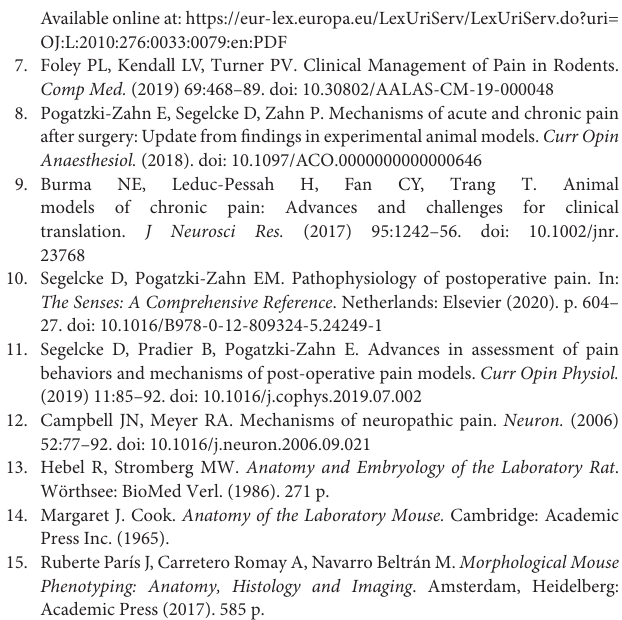
Supplementary Figure 1 | Exemplary detailed scoring for different surgical interventions in rats (A) and mice (B) according to the WWHow concept, showing the respective scoring points of the “Where”, “What” and “How” categories and the total score from which the severity is